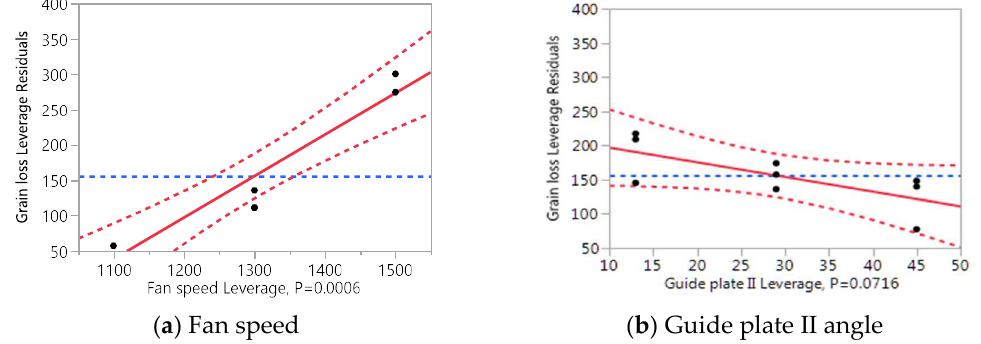
Figure 8. Effects of working parameters on grain loss with a confidence interval of 95%.